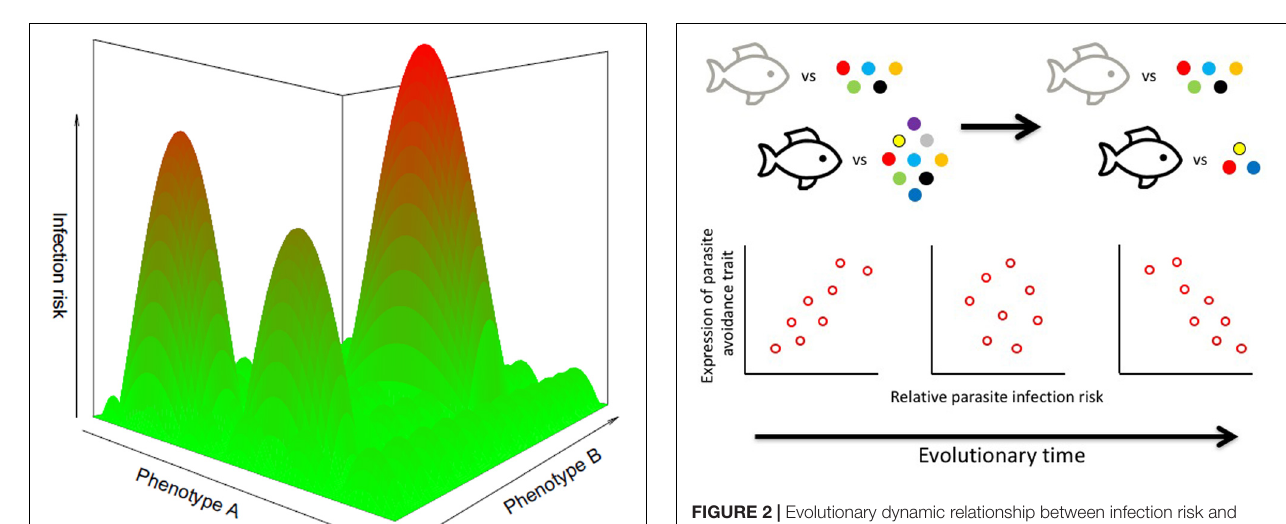
FIGURE 2 | Evolutionary dynamic relationship between infection risk and avoidance traits, as it shifts from positive to negative over evolutionary time. Species facing multiple parasite species (colored points) are under stronger selection to develop more pronounced avoidance strategies (dark shape outline) than those facing few parasites; over time, however, strong avoidance strategies may lead to the loss of parasite species. The different points on the graphs represent either distinct host species, or distinct populations of the same host species. NB: Scale on x -axis shows relative risk (e.g., parasite species richness), and not absolute risk; it allows comparison among points on the same graph, but not among